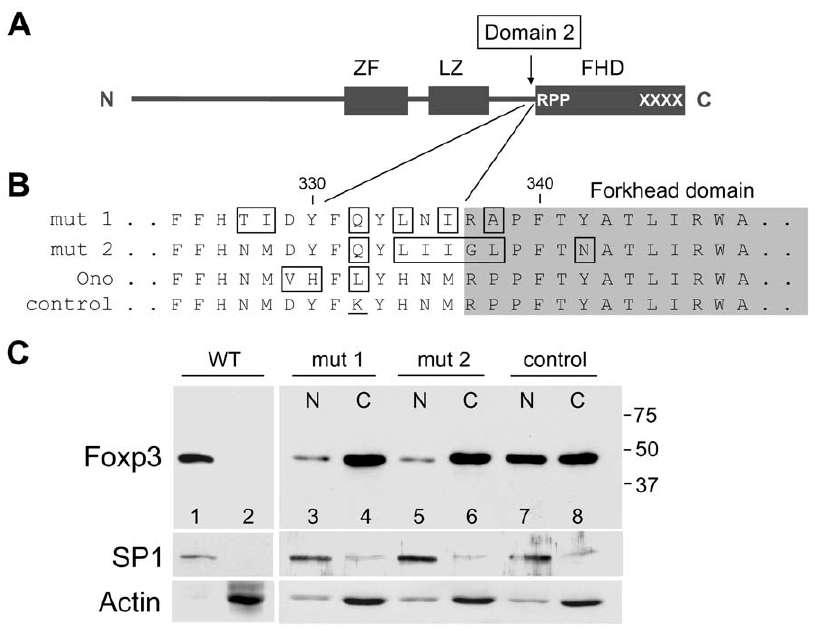
Figure 4. Sequences immediately N-terminal to the FHD (Domain 2) contribute to nuclear translocation of Foxp3. A. Schematic diagram of C-short Foxp3 mutant (XXXX N ). Additional mutations were introduced in order to identify the second domain that contributes to Foxp3 nuclear translocation. The arrow marks the location of Domain 2 and the converging lines lead to the sequences shown in B. B. Mutations in Domain 2 that impair the nuclear translocation ability of Foxp3. Mutant residues in mut 1, mut 2 of this study and of Ono (detailed sequence shown in Ono et al. [9]) are boxed. The 16 th lysine in the control C-short mutant is underlined. C. Western blot showing the impaired nuclear translocation ability of mutants 1 and 2 (lanes 3, 4 and 5, 6 versus lanes 7, 8). CD4 + cells were harvested one day after retroviral transduction. WT Foxp3 (lanes 1, 2) is from the same experiment but analyzed on a separate blot. Lower panels, SP1 and Actin controls. Abbreviation: mut designates mutant.